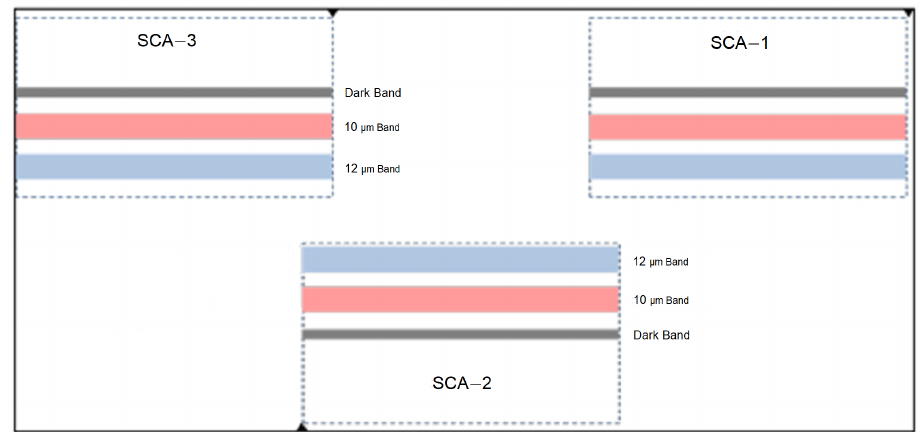
Figure 3. TIRS FPM-level offsets